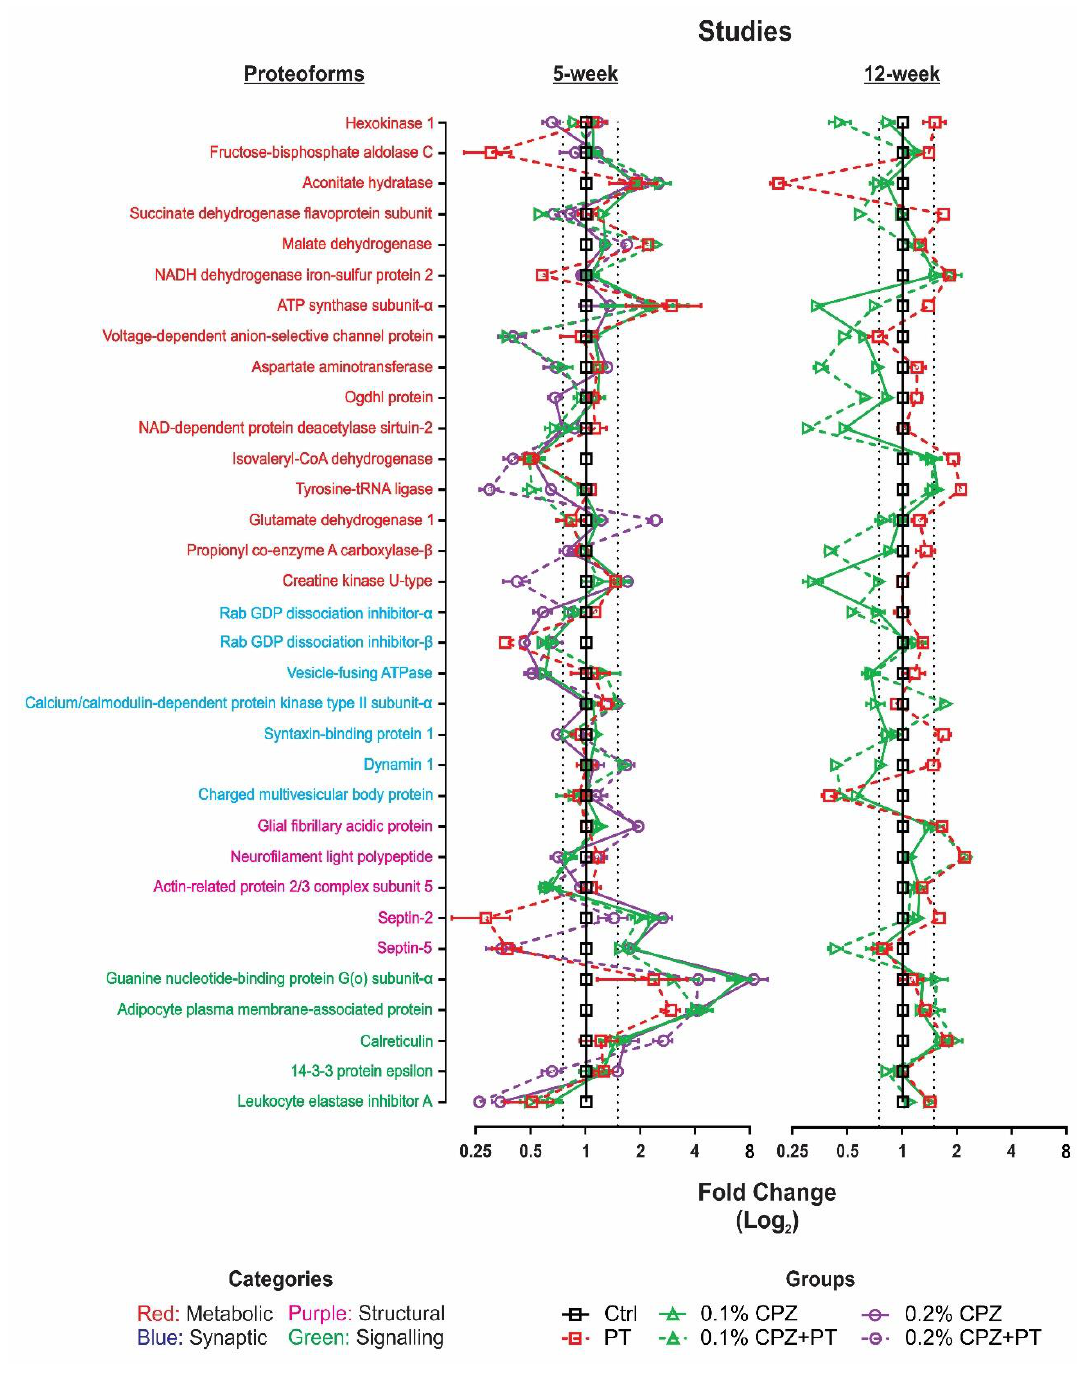
Figure 5. Log 2 fold changes in abundance for 33 proteoforms relative to Ctrl. Each point is the average change in spot volume ratio from all treated groups (PT, 0.1% CPZ, 0.1% CPZ + PT, 0.2% CPZ and 0.2% CPZ + PT) relative to Ctrls from the triplicate gels resolved for each of the 5- and 12-week samples. Only significant changes in abundance ( p < 0.05) that exceeded the established 1.5-fold criteria (dash lines) in at least 1 experimental group were selected for excision, processing, and protein identification. Solid and dashed lines connect the protein changes within each experimental group with and without PT injection, respectively. Proteoforms (top left) indicate the di ff erent functional categories including metabolic (red), synaptic (blue), structural (purple) and signalling (green). Analysis was based on n = 180 gels (5-week study) and, n = 120 gels (12-week study); n = 5 animals/group.